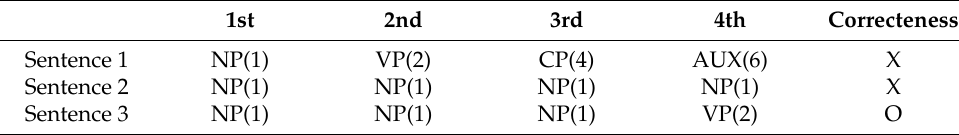
Table 2. Examples of sentences. 1st